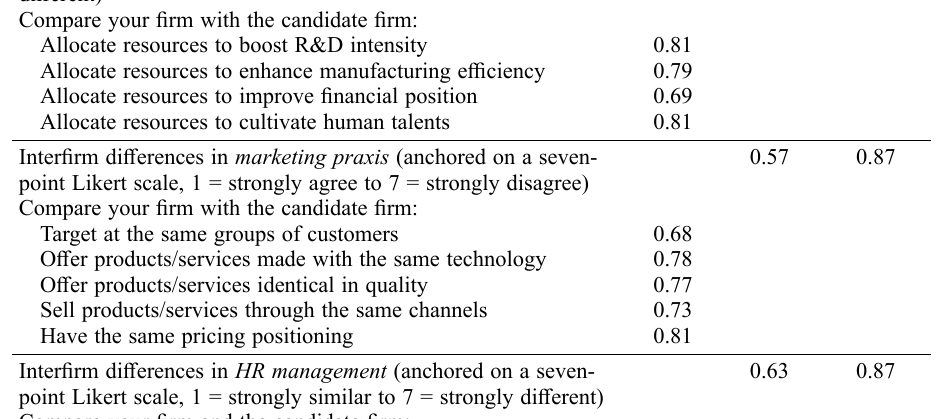
Average Construct Factor variance loadings extracted